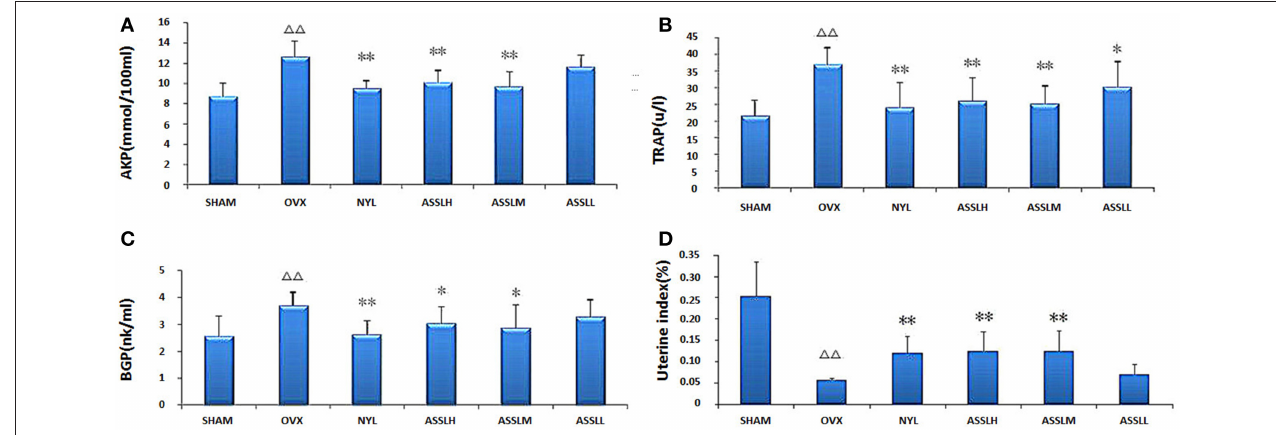
FIGURE 2 | Effects of nylestriol and total lignans on the serum alkaline phosphatase, tartrate-resistant acid phosphatase and osteocalcin of ovariectomized osteoporosis rat model (compared with sham operation group, 11 P < 0.01; the OVX model group, * P < 0.05, ** P < 0.01). (A) Alkaline phosphatase; (B) Tartrate-resistant acid phosphatase; (C) Osteocalcin; (D) Rat uterus index.